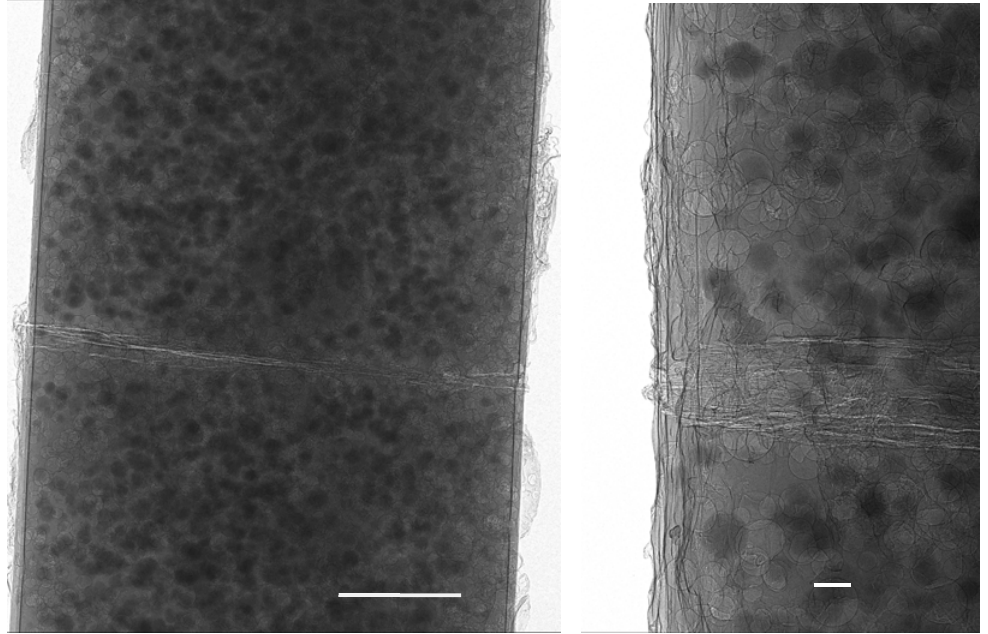
Figure 10. 2D X-ray phase-contrast images of the partially healed crack in a cylinder of a polymer. The solvent capsules appear as dark circular regions due to X-ray absorption whilst the edges of the empty capsules and the crack are highlighted by phase-contrast.